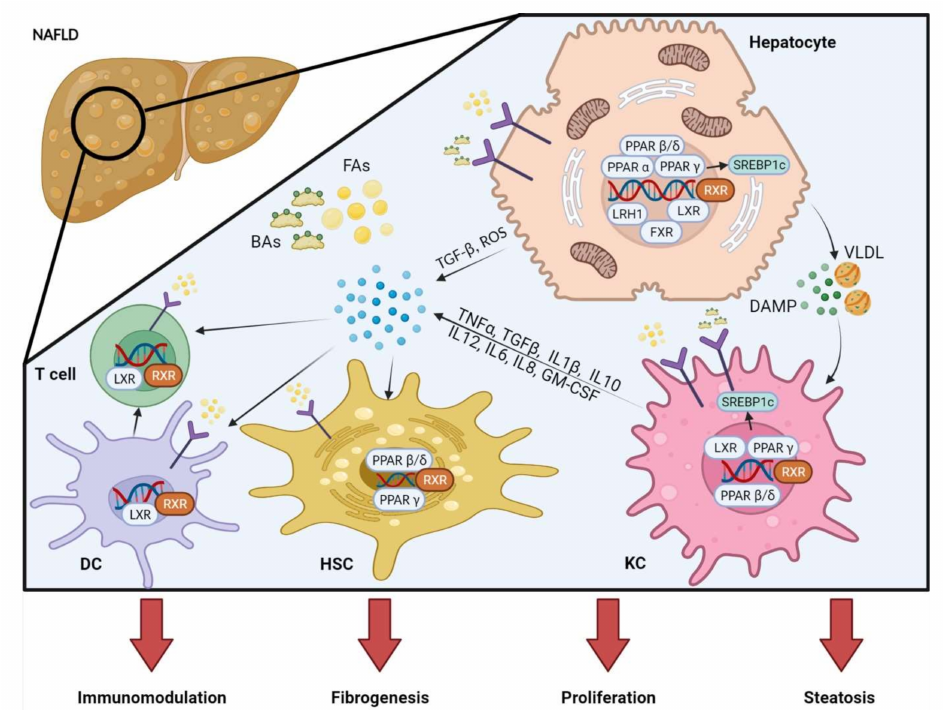
Figure 2. Nuclear receptors (NRs) modulate metabolism, inflammation, and fibrosis in NAFLD. Multiple NRs (e.g., PPAR α , PPAR β / δ , PPAR γ , FXR, LXR and LRH1) expressed by immune and liver parenchymal cells (hepatocytes, HSCs, macrophages, DCs and T cells) are activated by lipid deposition and bile acids. Binding RXR, NRs modulate lipid metabolism through downstream mediators (such as SREBP1c). In NAFLD, lipid-vesicle loaded hepatocytes secrete cytokines (such as TGF β ) and ROS to modulate the immune response. Hepatocyte-derived cytokines, FAs and Bas further shape the immune response and KC polarization. Coordinating with hepatocytes, activated KCs induce the activation of HSCs to myofibroblasts, which eventually promote fibrogenesis. In addition, activated DCs orchestrate the T cell immune response. NAFLD: non-alcoholic fatty liver disease; PPAR: peroxisome proliferator-activated receptor; FXR: farnesoid X receptor; LXR: liver X receptor; LRH1: liver receptor homolog 1; RXR: retinoid X receptor; SREBP1c: sterol regulatory element binding protein 1c; FAs: fatty acids; BAs: bile acids; HSC: hepatic stellate cell; KC: Kupffer cell; DC: dendritic cell; ROS: reactive oxygen species; TNF: tumor necrosis factor; TGF: transforming growth factor. (Created with Biorender.com, accessed on 23 February